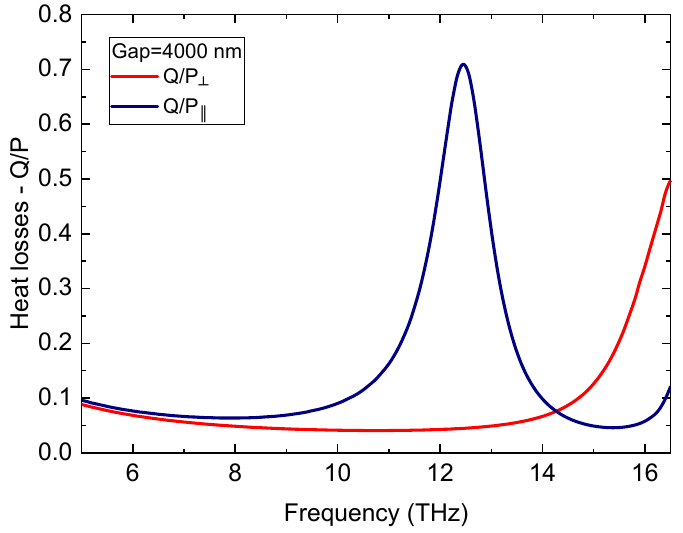
Figure 6. Percentage of heat losses (Q) for a spacing of 4000 nm in a dimer Bi 2 Se 3 microspheres system, for a radially and tangentially oriented QE.